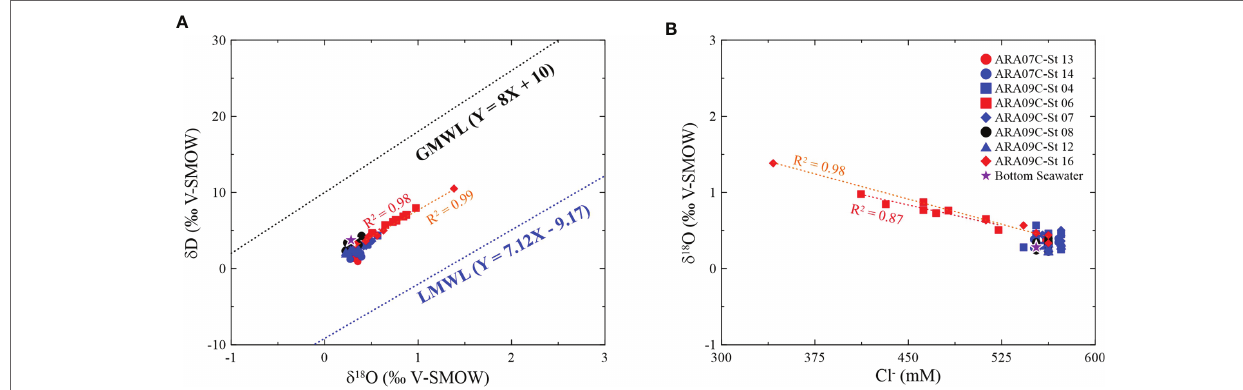
FIGURE 4 | Scatter plots of (A) δ D versus δ 18 O and (B) δ 18 O versus Cl - in bottom seawater (violet star; Site ARA09C-St 04) and pore fluids from the ARAON Mounds. The GMWL is the global meteoric water line ( Craig, 1961 ), and the LMWL is the local meteoric water line at Inuvik, Canada, by the Global Network of Isotopes in Precipitation (http://www-naweb.iaea.org/napc/ih/IHS_resources_gnip.html). Black color site: reference site without GHs and MDACs, blue color sites: observation of MDACs, and red color sites: observation of GHs and MDACs.